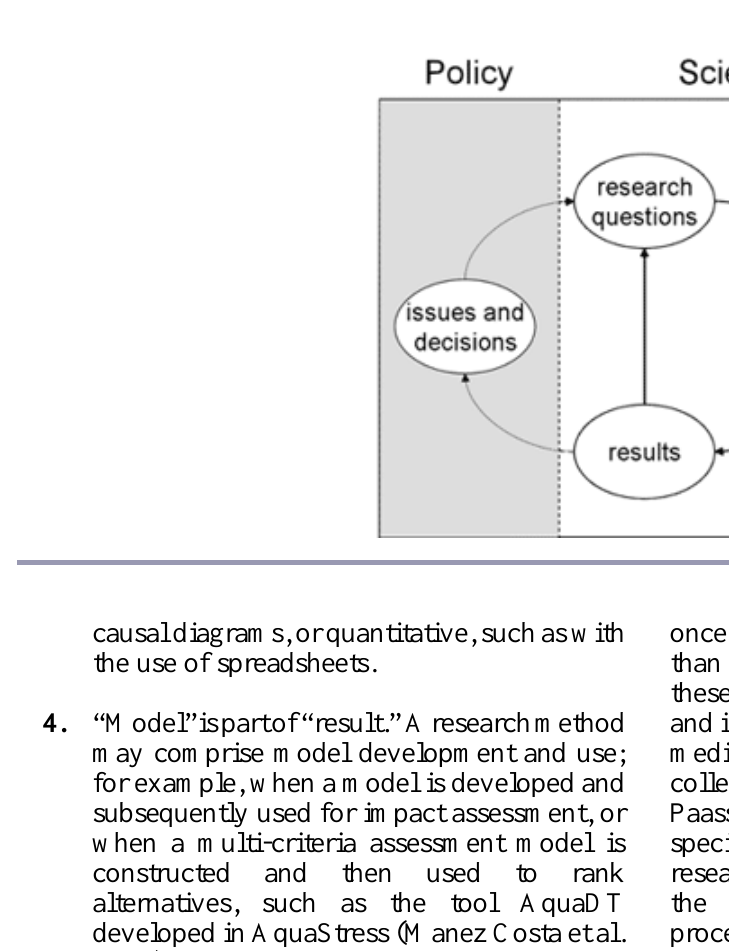
Fig. 1. Scientific research linked to a policy